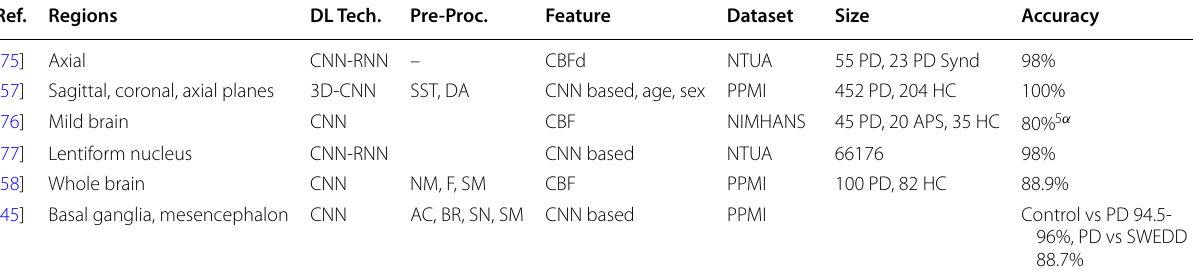
Pre-Proc. pre-processing, Synd syndrome, n α – n fold cross-validation, AC alignment correction, SWEDD scans without evidence for dopaminergic deficit, CBF CNN- based features